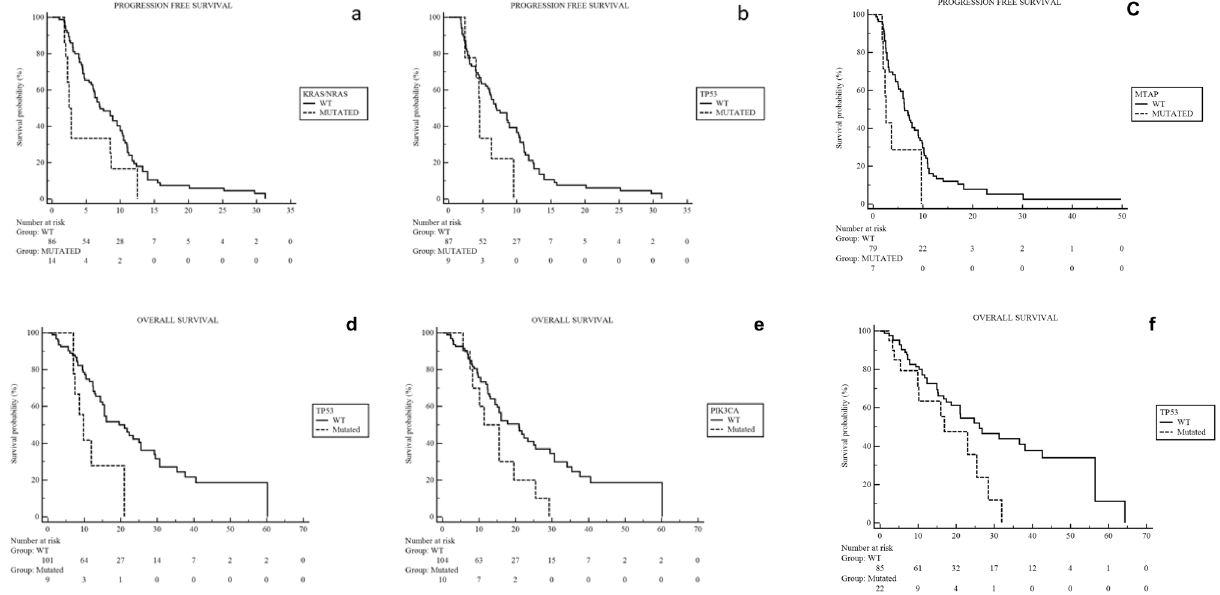
Figure 4. Kaplan Meyer curves of PFS and OS from first line therapy according to the altered genes with prognostic